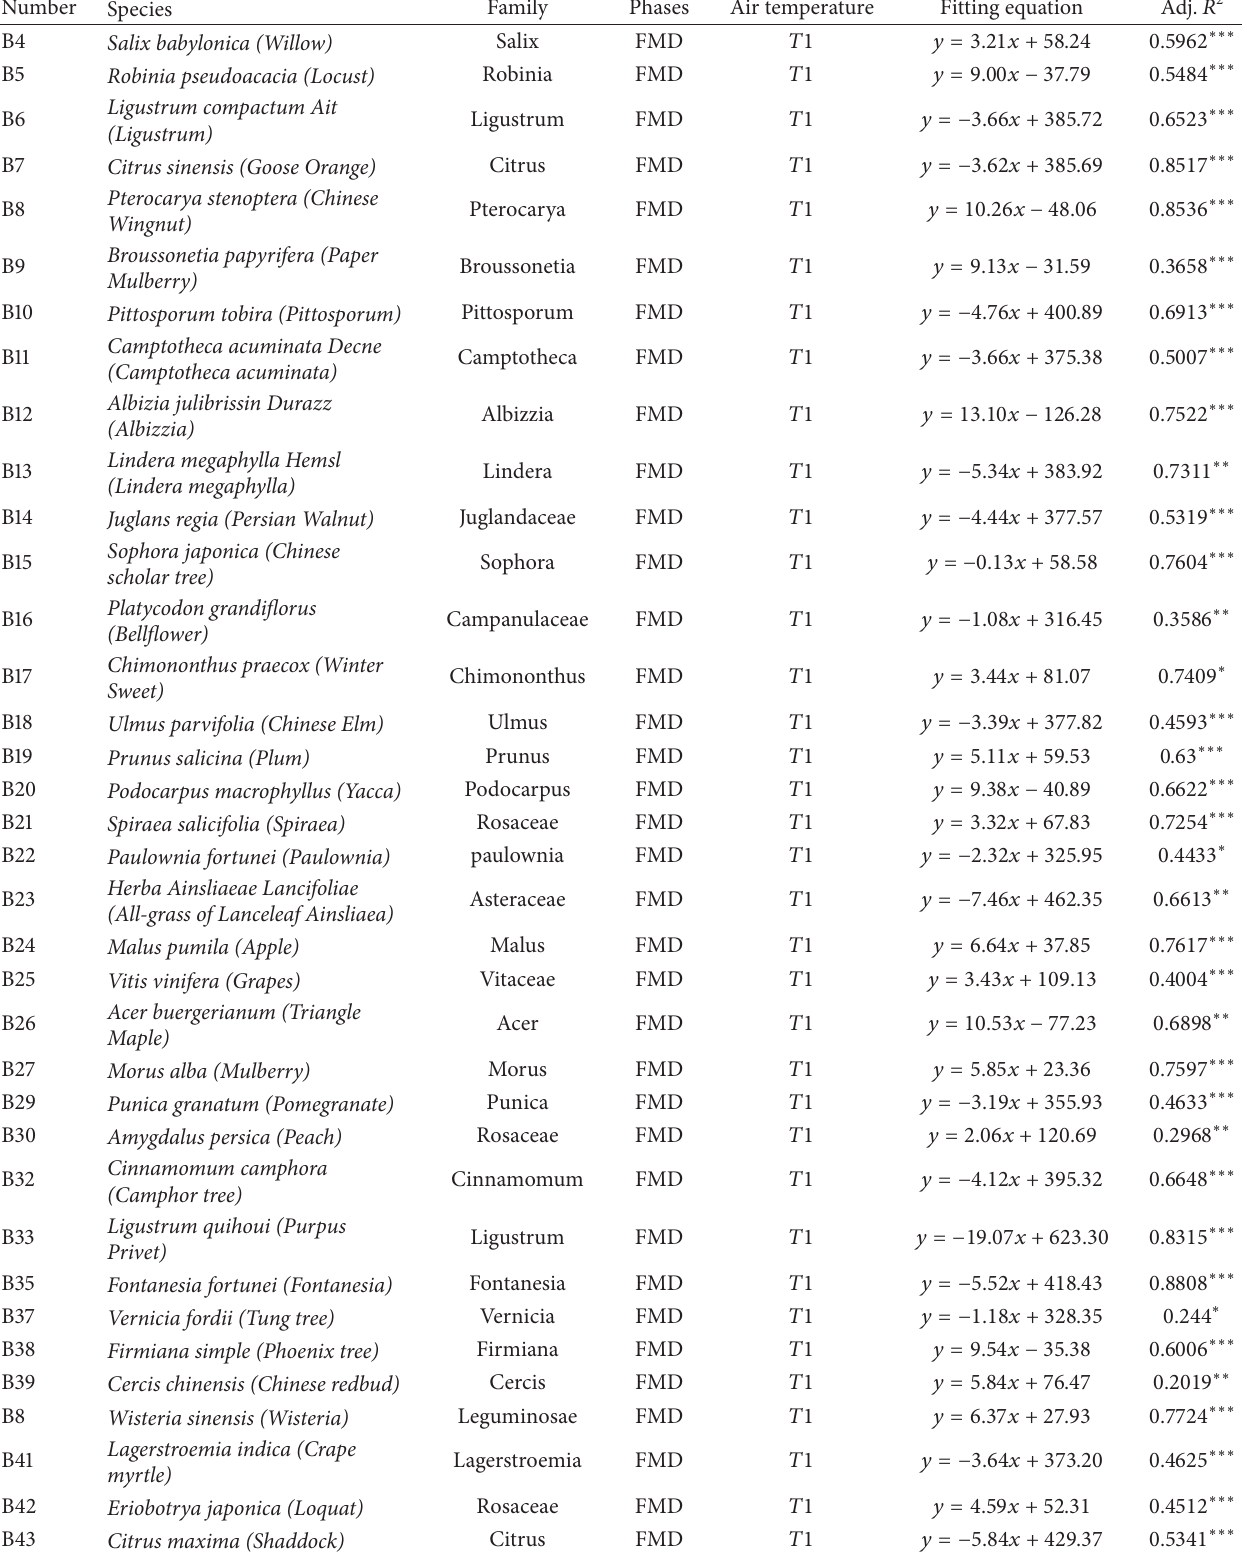
Table 2: Fitting equation of fruit maturity date and air temperature ( 𝑇1 ) in